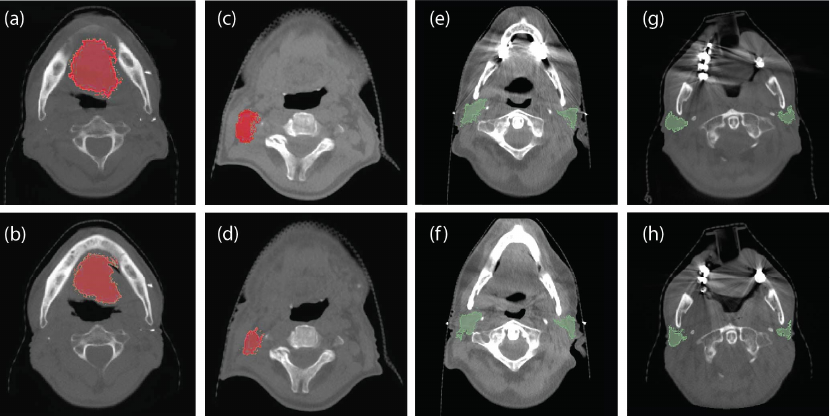
Figure 1. CBCT scans for patients at baseline (week 0) and at the end of the RT treatment sessions with significant and non-significant changes for the CTV tumor region (red mask) and the PG tumor region (green mask). Specifically: ( a ) CTV ROI of patient #3 at baseline; ( b ) CTV ROI of patient #3 at the end of the RT treatment sessions (non-significant changes); ( c ) CTV ROI of patient #14 at baseline; ( d ) CTV ROI of patient #14 at the end of the RT treatment sessions (significant changes); ( e ) PG ROI of patient #3 at baseline; ( f ) PG ROI of patient #3 at the end of the RT treatment sessions (non-significant changes); ( g ) PG ROI of patient #18 at baseline; ( h ) PG ROI of patient #18 at the end of the RT treatment sessions (significant changes).